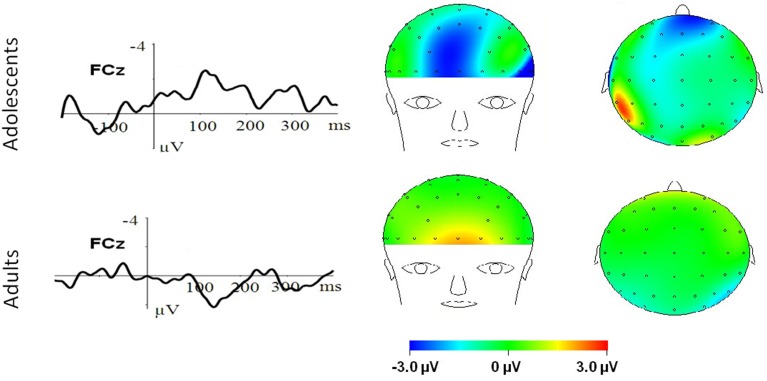
MN–Neutral difference ERPs at FCz, and the topographical distributions of the voltage amplitudes of MN–Neutral difference ERPs in the 210–290 ms time interval in adolescents (top panel) and adults (bottom panel).